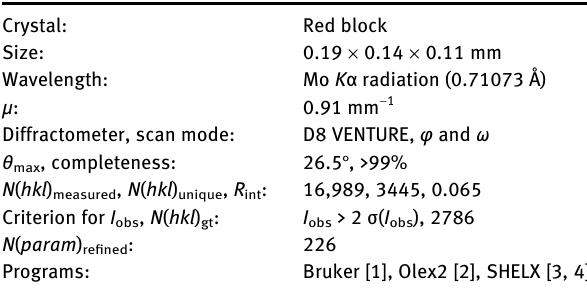
Table  : Data collection and